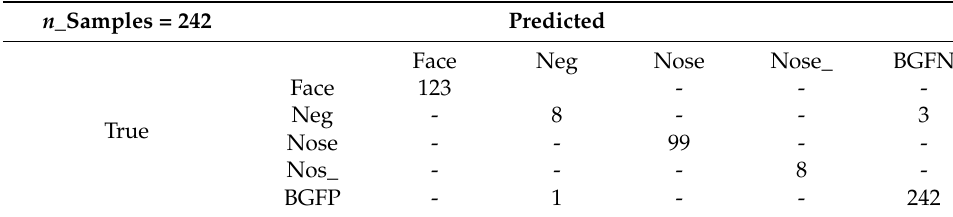
Table 3. Confusion Matrix of Yolo Object Detection Model for test set.